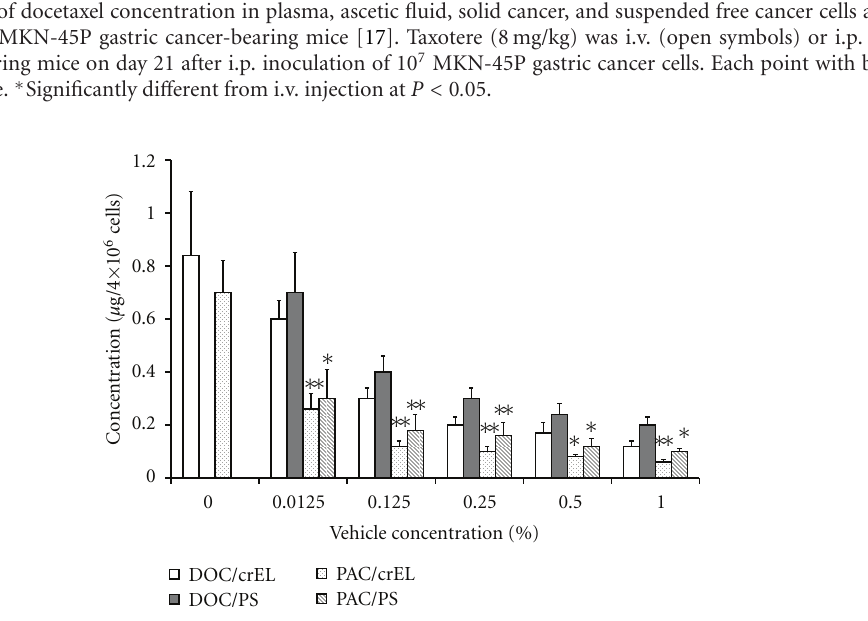
Figure 7: E ff ects of surfactants on uptake of paclitaxel and docetaxel in AH130 cells. Cells were treated with 3 μ g/mL of docetaxel (DOC) or paclitaxel (PAC) dissolved with 0.125% ethanol (0) or the indicated concentrations of crEL or PS-80 (PS) for 30min. The data at 0.0125% concentration of these surfactants are taken from [15]. Each column with bar represents the mean ± SD of at least three experiments performed in triplicate. ∗ , ∗∗ Significantly di ff erent from docetaxel at P < 0 . 05 and 0.01,